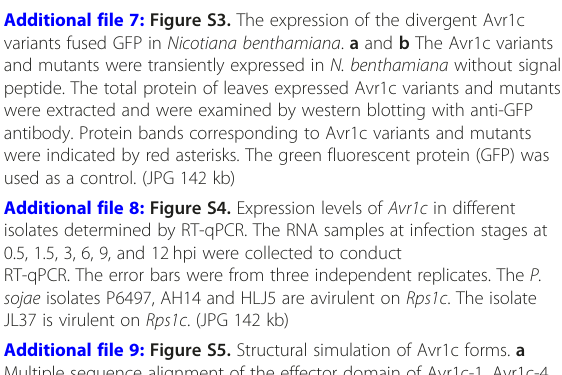
Additional file 6: Table S4. d N /d S analysis of pairwise comparisons of Avr1c alleles. (XLS 39